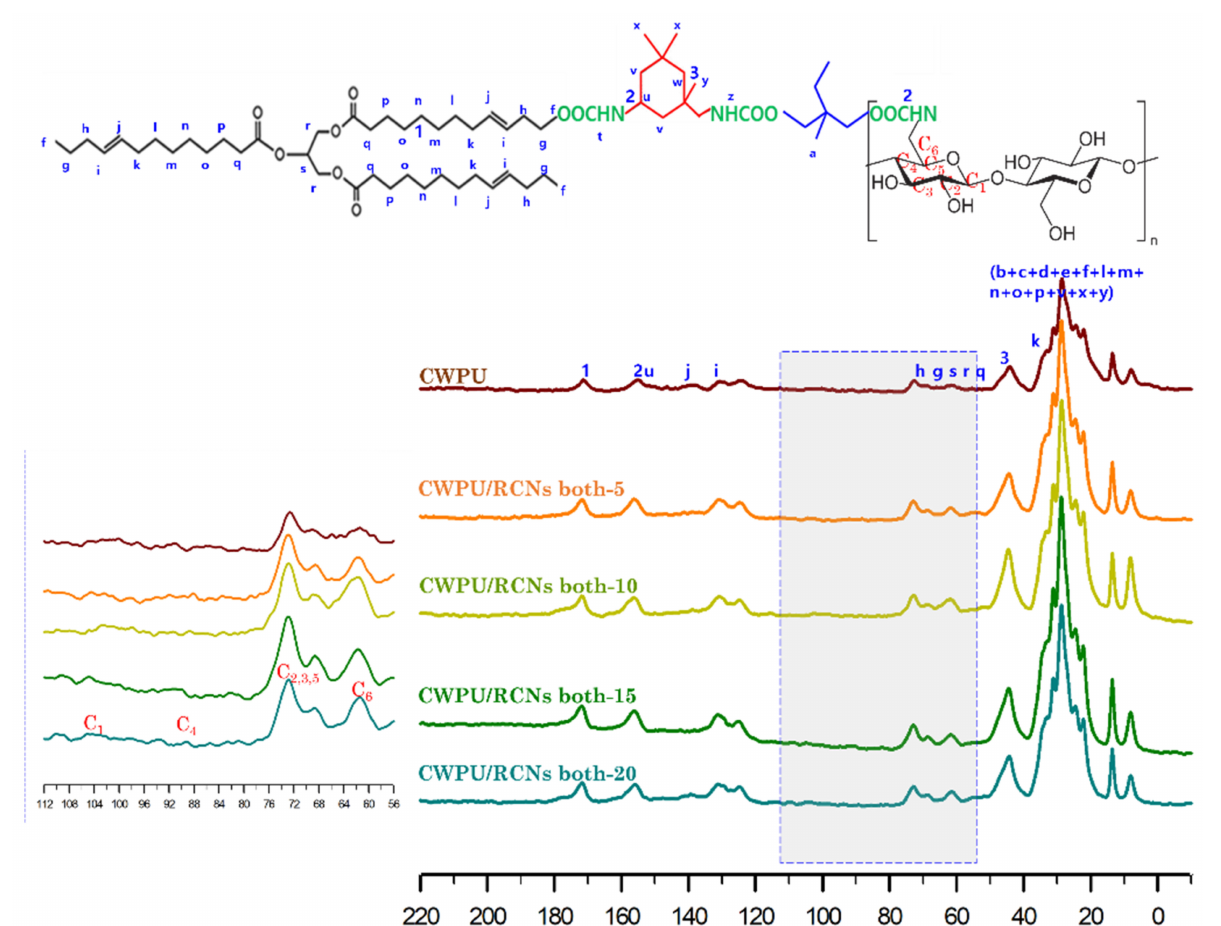
Figure 6. Solid state 13 C NMR spectra of the prepared CWPU and CWPU/RCNs nanocomposite films according to RCNs